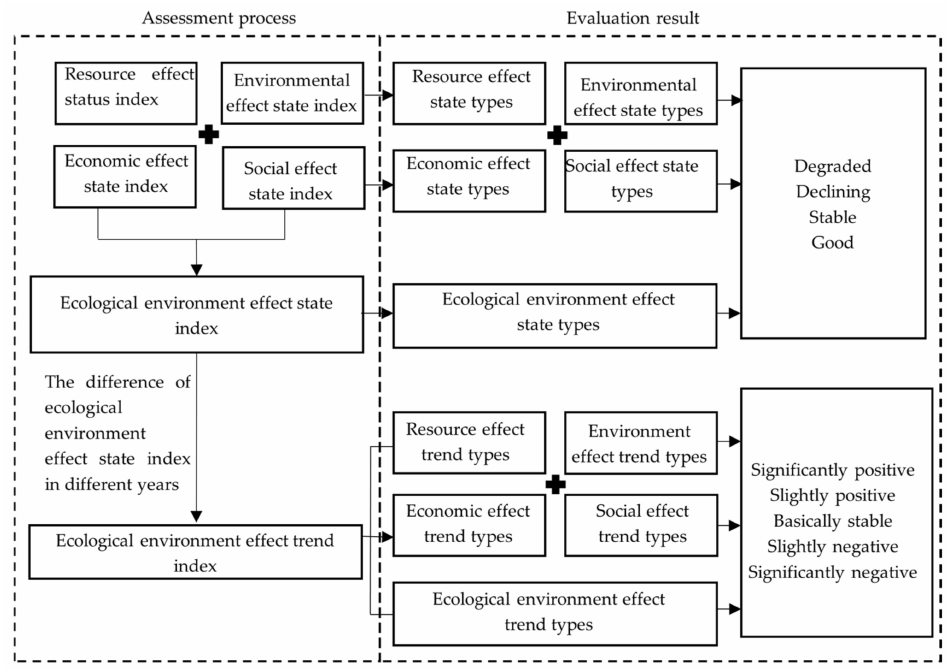
Figure 2. Overall thoughts on the evaluation of ecological environmental effect of land